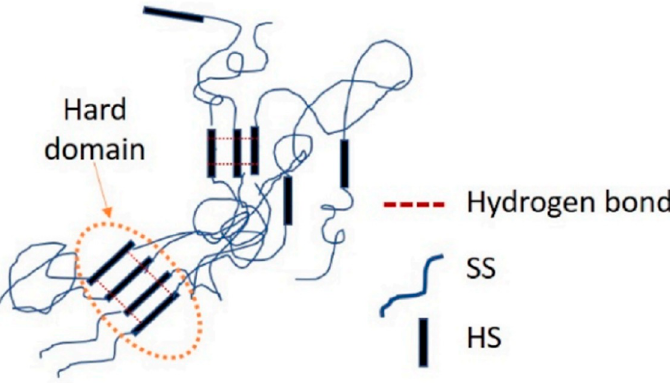
Figure 1. ( a ) Schematic illustration for the structure of TPU. Figure 1. Schematic illustration for the structure of